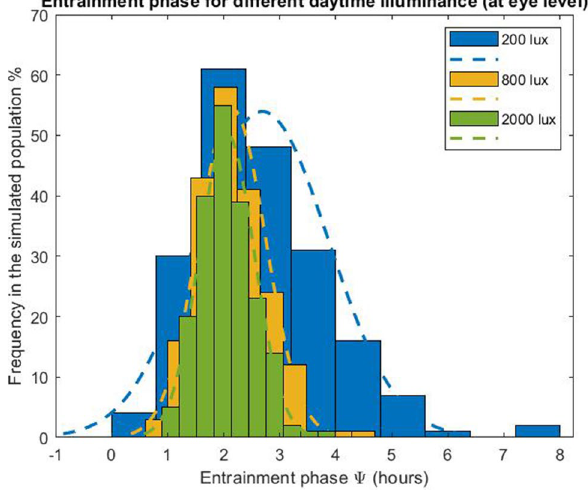
Figure 3. Entrainment phase angle distribution for a population of 200 simulated individuals with a normally distributed intrinsic circadian period with means (± SD) of 24.15 (± 0.2) h 33 . Illuminances represent the corneal light exposure (i.e., at the eye position). Results are presented for three different daytime (wake-19:00) illuminances (L